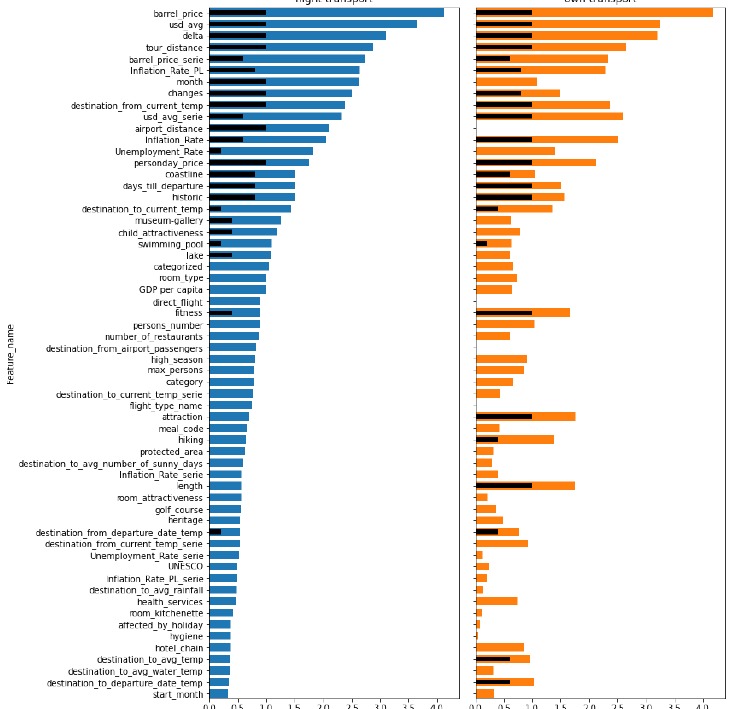
Figure 10. Final evaluation of features for n = 21. Blue and orange bars present the sum of the weights obtained by all five methods. Black bars indicate the result obtained using sequential backward